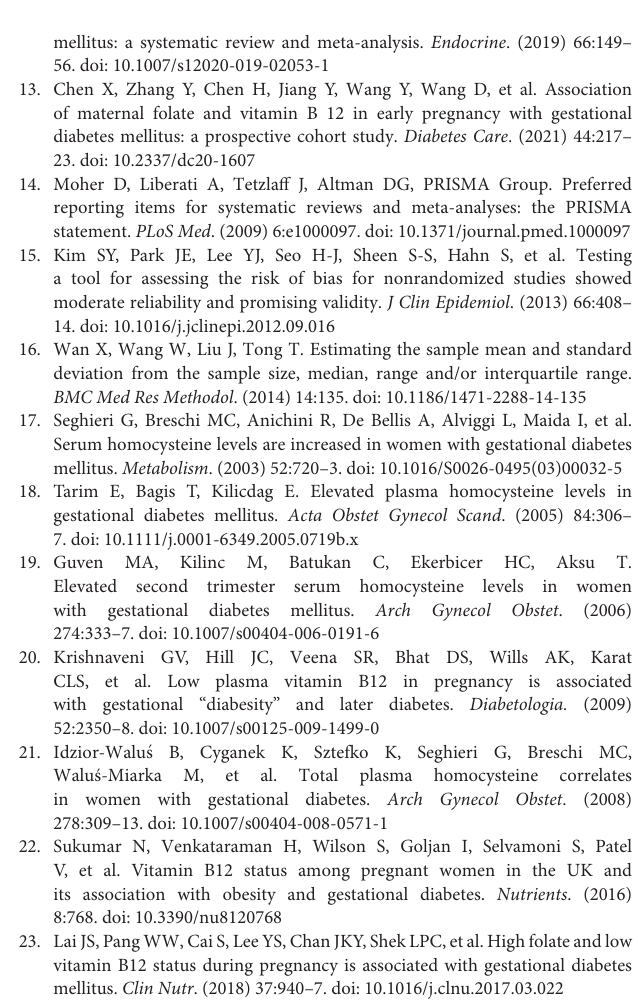
Supplementary Figure 1 | Funnel plot for the meta-analysis serum folate concentration during pregnancy between GDM and non-GDM groups. Supplementary Figure 2 | Funnel plot for the meta-analysis of serum vitamin B12 concentration during pregnancy between GDM and non-GDM groups. Supplementary Figure 3 | Funnel plot for the meta-analysis of adjusted odds ratios assessing relationship between GDM and RBC folate (as continuous variable). Supplementary Figure 4 | Funnel plot for the meta-analysis of adjusted odds ratios assessing relationship between GDM and serum folate (as continuous variable). Supplementary Figure 5 | Meta-analysis of adjusted odds ratios assessing relationship between GDM and vitamin B12 (as continuous variable). Supplementary Table 1 | Search strategy and results of PubMed database. Supplementary Table 2 | Risk of bias